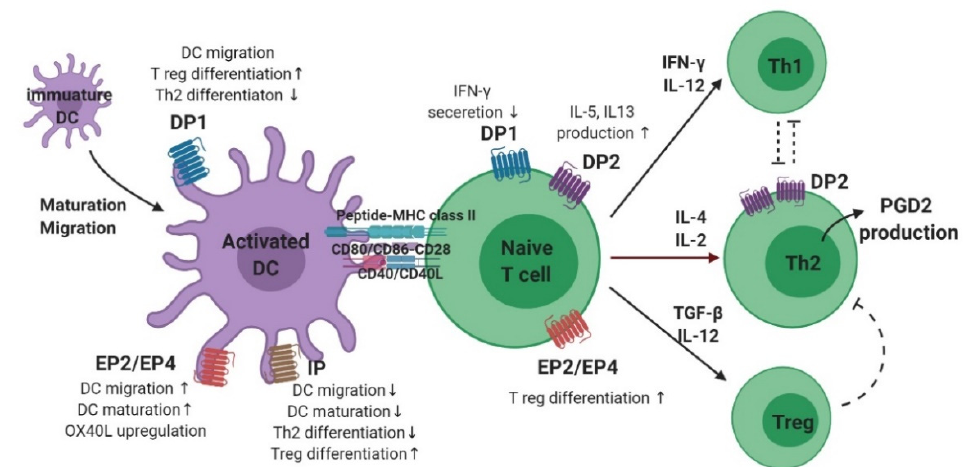
Figure 3. The role of prostaglandins and their receptors in dendritic cell–T cell interaction and Th2 differentiation.